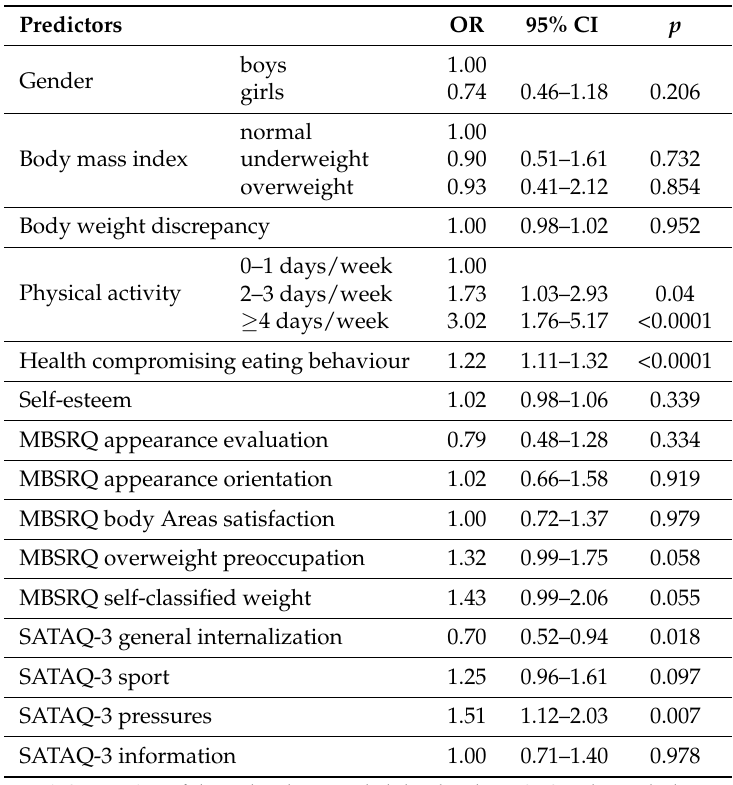
Table 6. Multiple regression analysis predicting health compromising physical activity behaviours from study